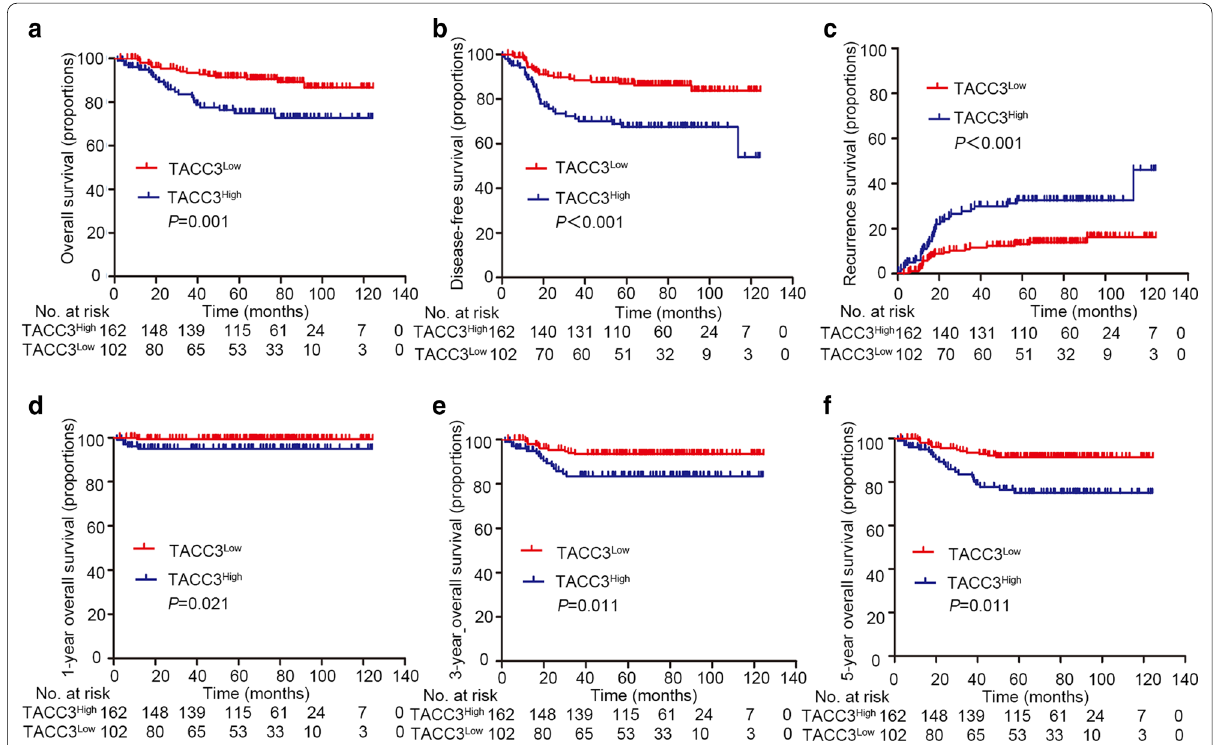
Fig. 3 Association of TACC3 expression and survival of patients with endocervical adenocarcinoma (ECA). a Correlation of TACC3 expression and overall survival determined in a tissue microarray (TMA) cohort including 264 patients by Kaplan–Meier analysis. b Disease‑free survival of the same TACC3 TMA cohort. c Curve for relapse evaluated according to TACC3 expression level. d – f 1‑, 3‑ and 5‑year overall survival (OS)of the same TACC3 TMA cohort. The life table is shown below each